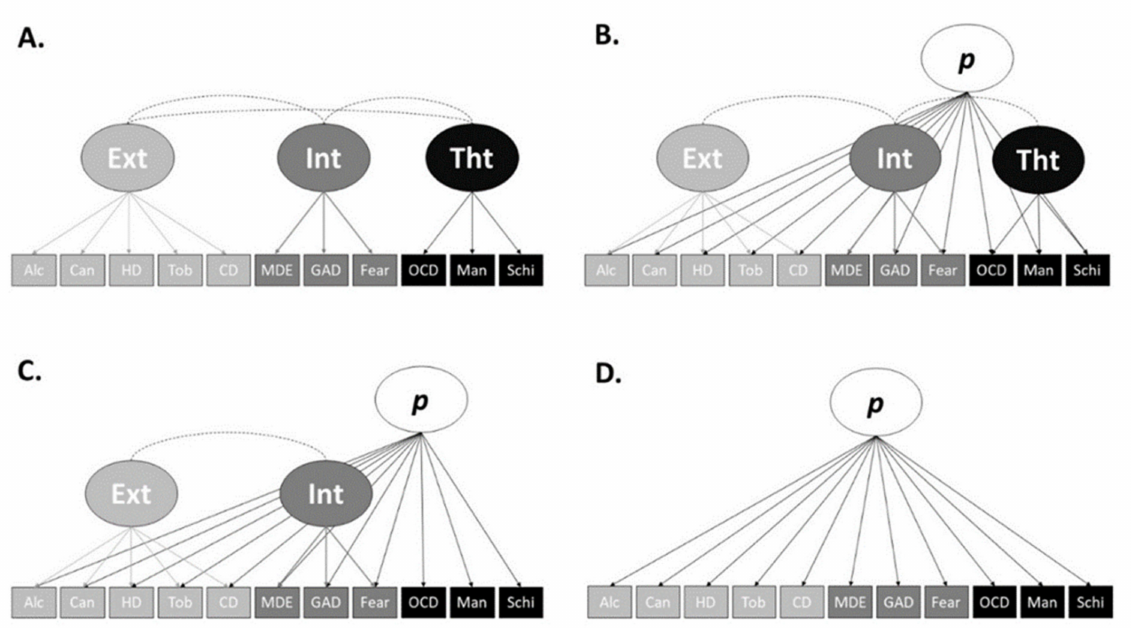
Figure 2. Note. Alc = alcohol; Can = cannabis; HD = hard drugs; Tob = tobacco; CD = conduct disorder; MDE = major depressive episode; GAD = generalized anxiety disorder; Fear = fears and phobias; OCD = obsessive-compulsive disorder; Man = mania; Schi = schizophrenia; Ext = externalizing; Int = internalizing; Tht = thought disorder. ( A ) Correlated factors model; ( B ) full bifactor model; ( C ) revised bifactor model; ( D ) single-factor